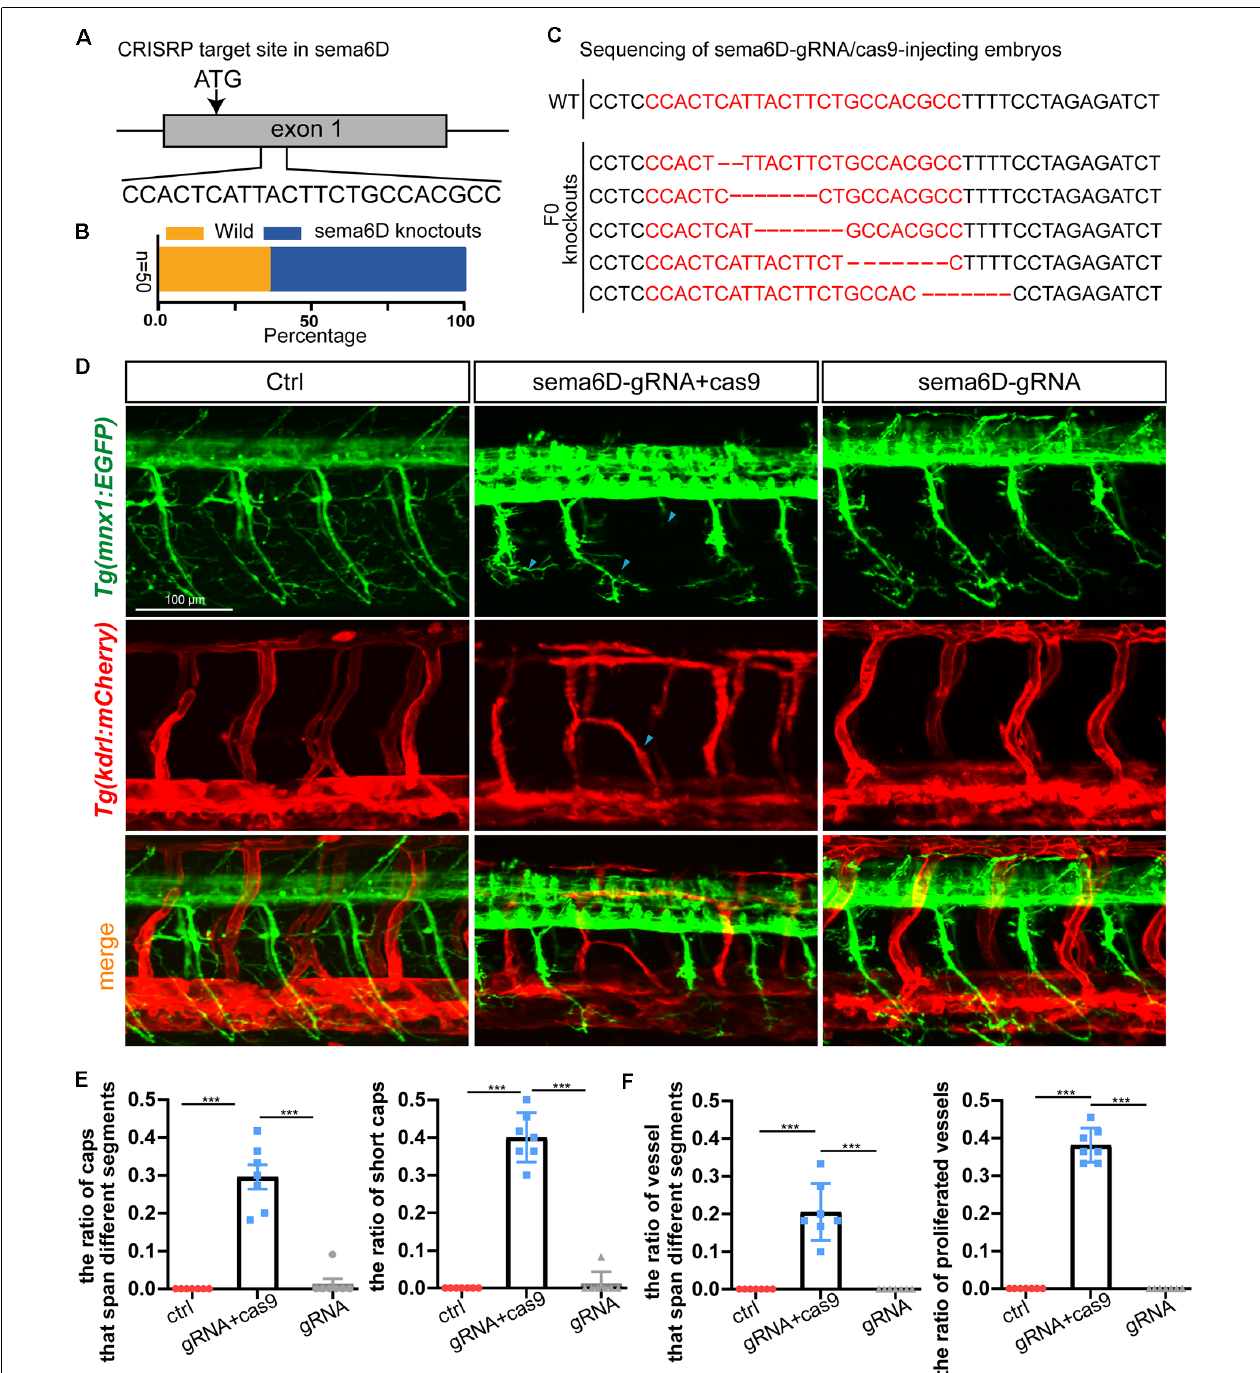
FIGURE 5 | Knockout of sema6D caused both aberrant phenotypes in PMNs and ISVs. (A) Schematic diagram showing the targeting site of the gRNA on the sema6D gene. Starting codon (ATG) site is indicated by arrow. (B) The statistics of the ratio of wildtype to mutant sequences ( n = 50). (C) Knockout patterns of sema6D -gRNA/cas9-injecting embryos by sequencing. (D) Confocal imaging analysis of primary motor neurons and intersegmental vessels in control and the F0 generation of the injected Tg(mnx1:EGFP::kdrl:ras-mCherry) zebrafish at 48 hpf, blue arrowheads indicate aberrant PMN and ISV. (E) The statistical analysis of the ratio of aberrant axonal projection of Caps ( P = 0.0006) and short Caps ( P = 0.0006) in the wild, F0 knockouts, and cas9 negative control at 48 hpf ( n = 7). About 9–11caps were used for statistics per zebrafish. Mann-Whitney test. Values with *** above the bars are significantly different ( P < 0.001). (F) The statistical analysis of the ratio of vessels that span different segments ( P = 0.0006) and the ratio of proliferated vessels ( P = 0.006) in the wild, F0 knockouts, and cas9 negative control at 48 hpf ( n = 7). About 9–12 ISVs were used for statistics per zebrafish. Mann-Whitney test. Values with *** above the bars are significantly different ( P < 0.001).